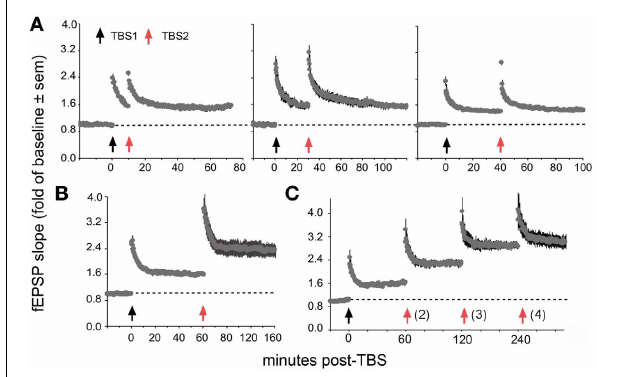
FIGURE 7 | Spaced stimulation augments LTP but only with delays of about 1h. Plots show effects of a first (TBS1) and second (TBS2) round of theta stimulation on fEPSP responses. (A) TBS1 (black arrow) reliably increases fEPSPs by about 50% above baseline whereas TBS2 (red arrow) applied 10 (left), 30 (middle) and 40 (right) min later does not augment the level of potentiation. (B) TBS2 applied 60min after TBS1 doubles the level of potentiation. (C) TBS3 further augments potentiation if delayed by 60min whereas a similarly delayed TBS4 has little effect suggesting that potentiation approaches ceiling levels after 3 spaced theta trains. Modified from Kramar et al.